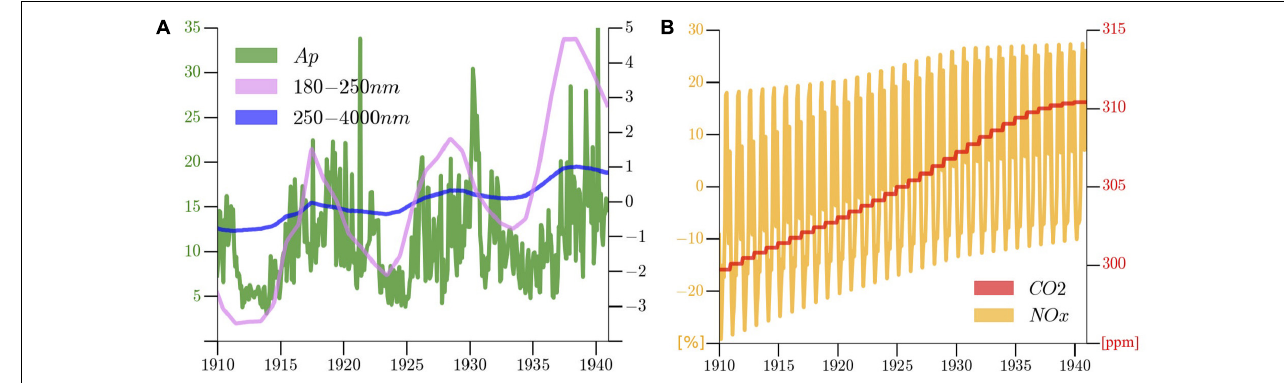
FIGURE 1 | The model boundary conditions for 1910–1940 period: (A) natural factors: Ap index describing energetic particle precipitation intensity, relative solar 180–250 nm irradiance change (%) with respect to 1910–1940 period and solar 250–4000 nm irradiance change (